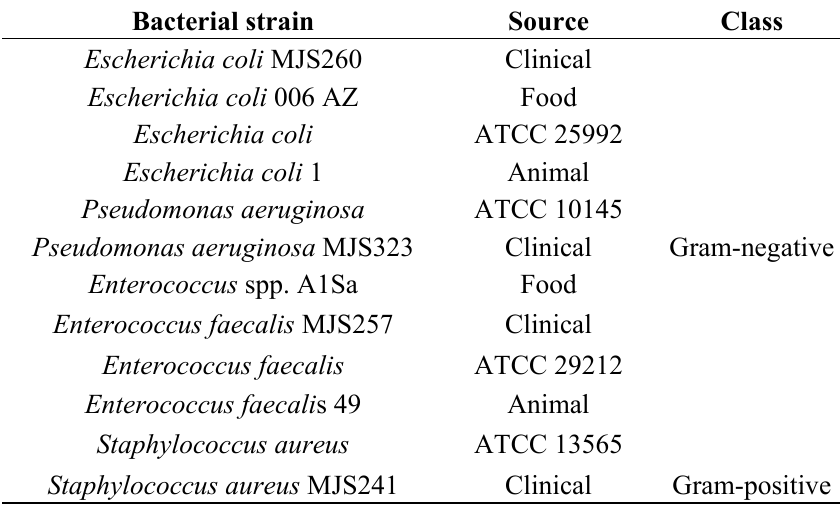
Table 8. Bacterial strains tested in the antibacterial